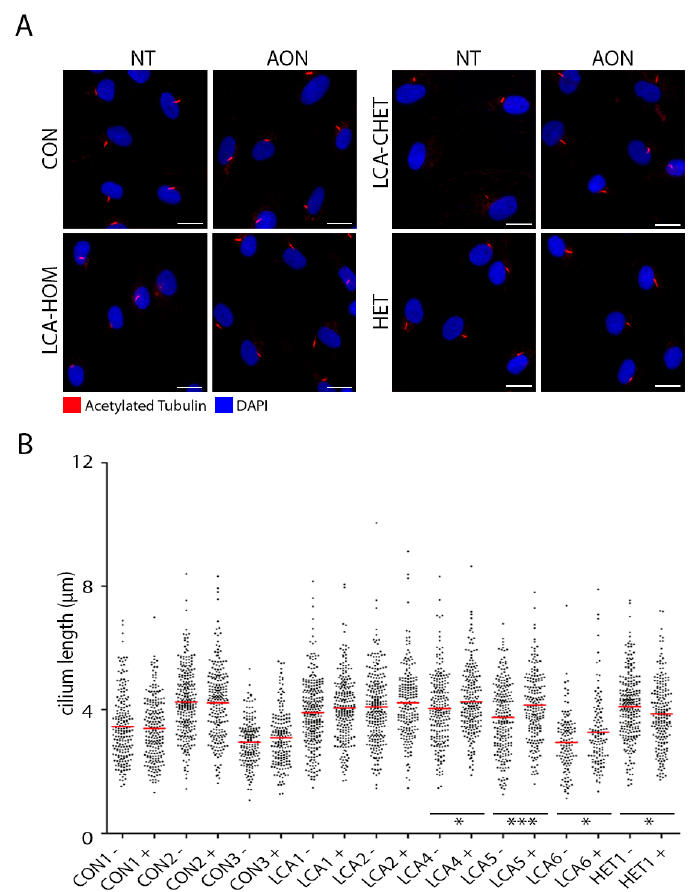
Figure 3. Cilium length assessment in fibroblast cells treated with AONs. ( A ) Representative images of a control (CON), a homozygous LCA (LCA-HOM), a compound heterozygous LCA (LCA-CHET) and carrier (HET) cell line. Nuclei are stained with DAPI (blue) and the axoneme of the cilia using Acetylated Tubulin as a marker (red) in non-treated (NT) and AON-treated (AON) cells. Scale bar represents 20 µm; ( B ) Cilium length analysis of all fibroblast cell lines employed for ciliation studies in the non-treated ( − ) and AON-treated (+) situation. Control (CON1, CON2 and CON3), homozygous LCA (LCA1 and LCA2), compound heterozygous (LCA4, LCA5 and LCA6) and heterozygous carrier (HET1) cell lines were used in this study. Each dot depicts the length of one cilium and the red line the average length per group. Statistical analysis was performed using Student’s t -test. p -Values are indicated in the figure. * p -value < 0.05 and *** p -value < 0.001.